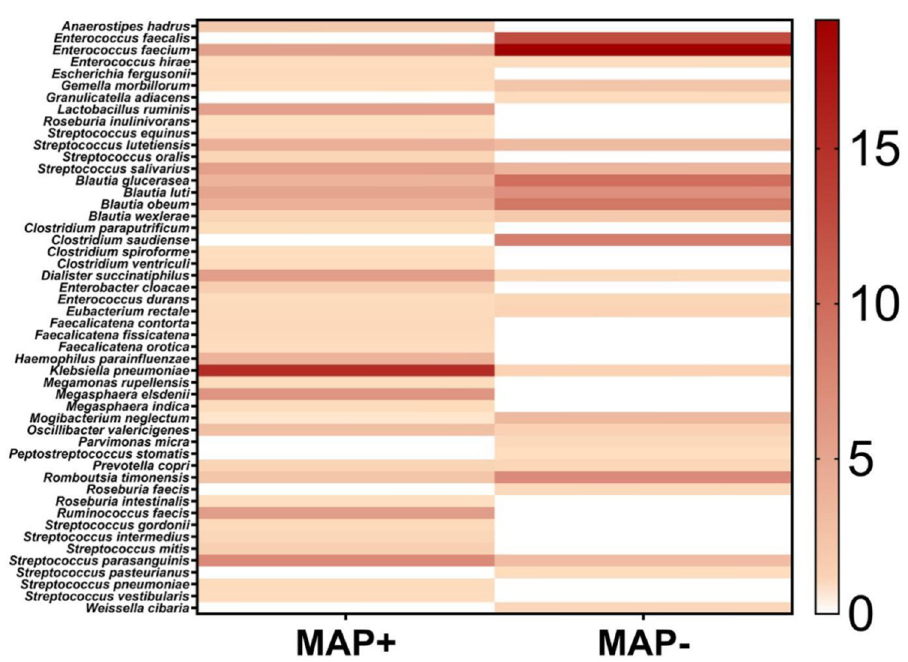
Fig 4. Heat map of the relative abundances of the most common species in the microbiome data of MAP+ and MAP- groups of patients with gastrointestinal diseases.